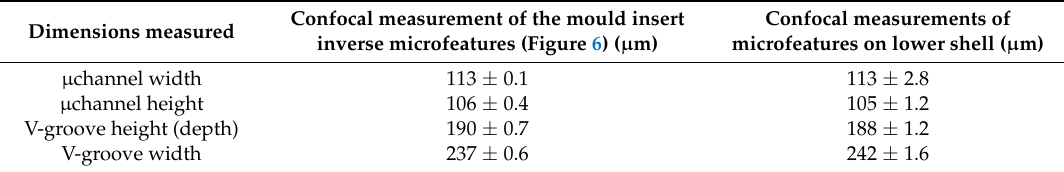
Table 2. Comparison between the measurements on the mould insert (Figure 6) and on the lower shell in PMMA.